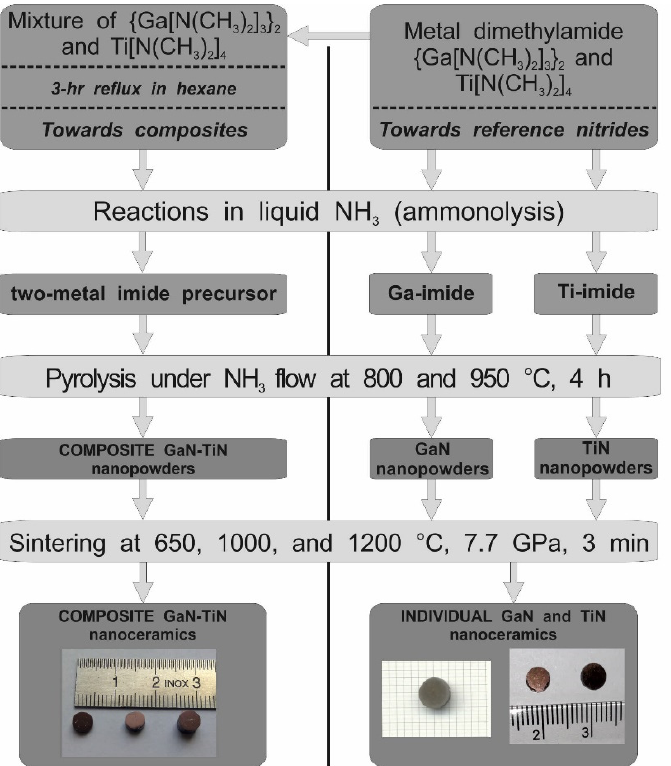
Figure 1. Sequence of experimental steps in anaerobic preparation and subsequent high-pressure and high-temperature sintering of composite and individual nanopowders in the system GaN–TiN. Snapshots of typical nanoceramics are shown at the bottom: left—brown composite pellets; right—gray GaN pellet and golden-brown TiN pellets.